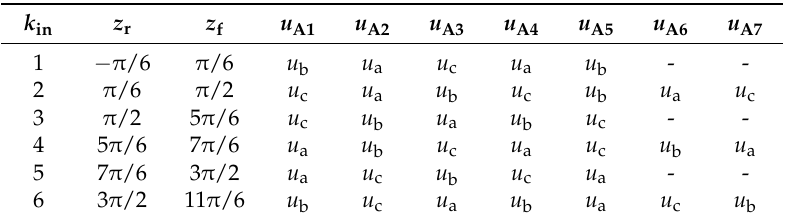
Table 3. Value of u A λ , z r and z f when k in changes from 1 to 6.